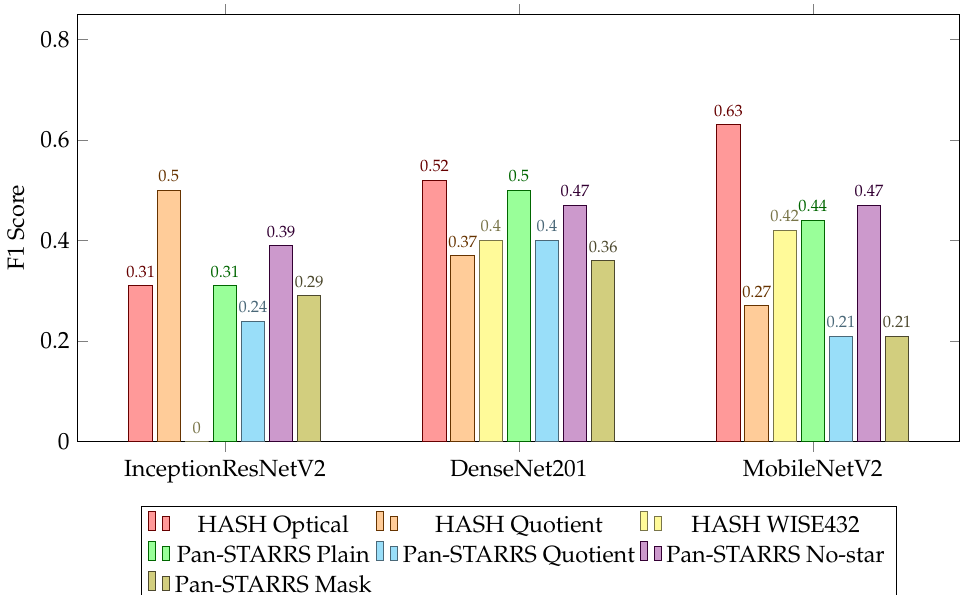
Figure 13. Round planetary nebulae morphology classification F1 score using the Test set from HASH DB and